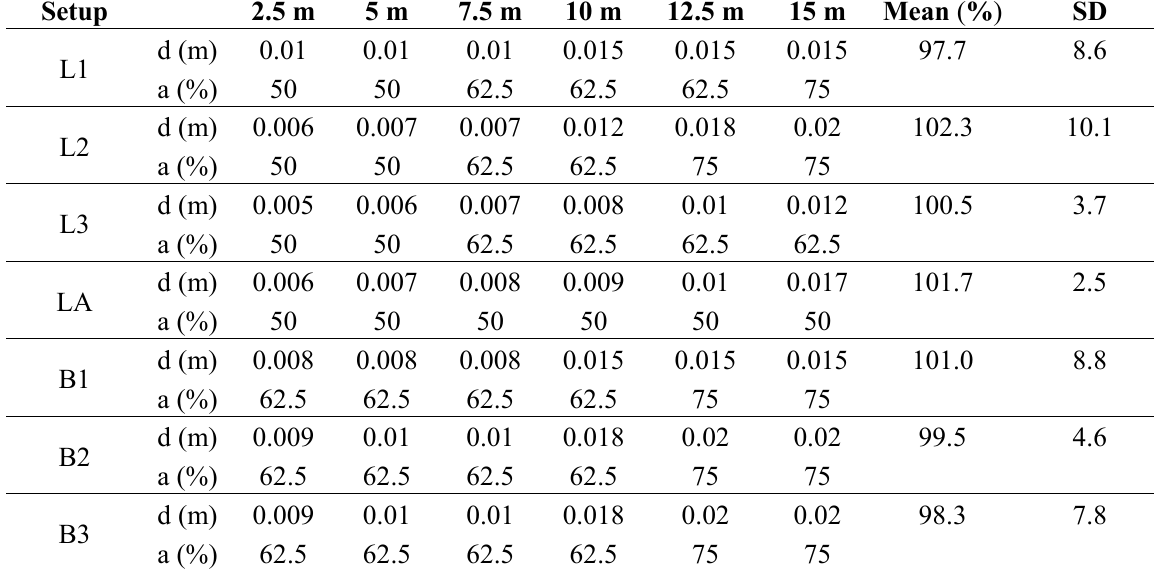
Table 4. Overview of the distance-based configuration at different distances and percentage of ghost points detected using the optimized distance-based filter. d (m): distance threshold, a (%): allocation threshold. L1: leaf reflectance 10%, L2: